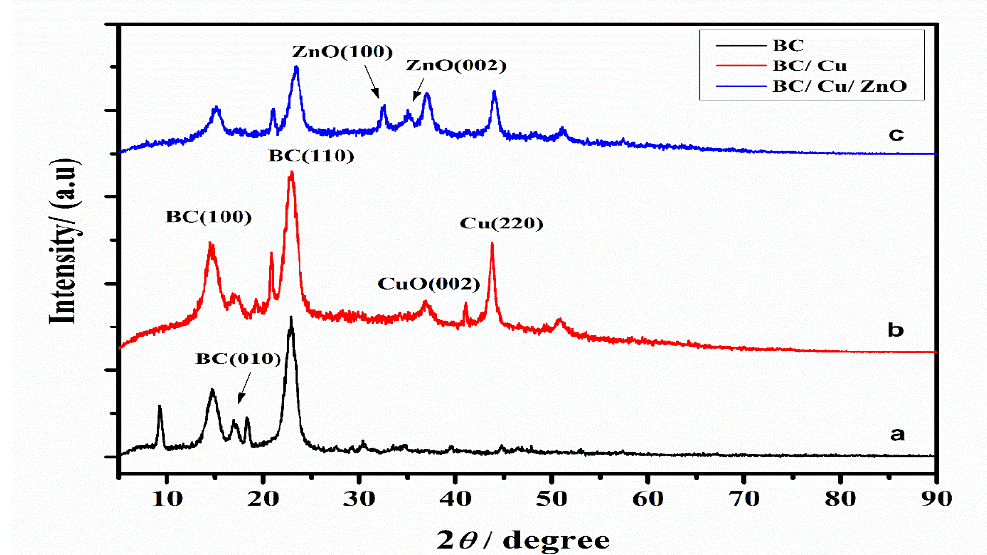
Figure 7. The X-ray diffraction (XRD) representations of three samples: ( a ) bacterial cellulose; ( b ) bacterial cellulose/copper nanocomposite; ( c ) bacterial cellulose/copper/zinc oxide nanocomposite. ( b ) bacterial cellulose / copper nanocomposite; ( c ) bacterial cellulose / copper / zinc oxide